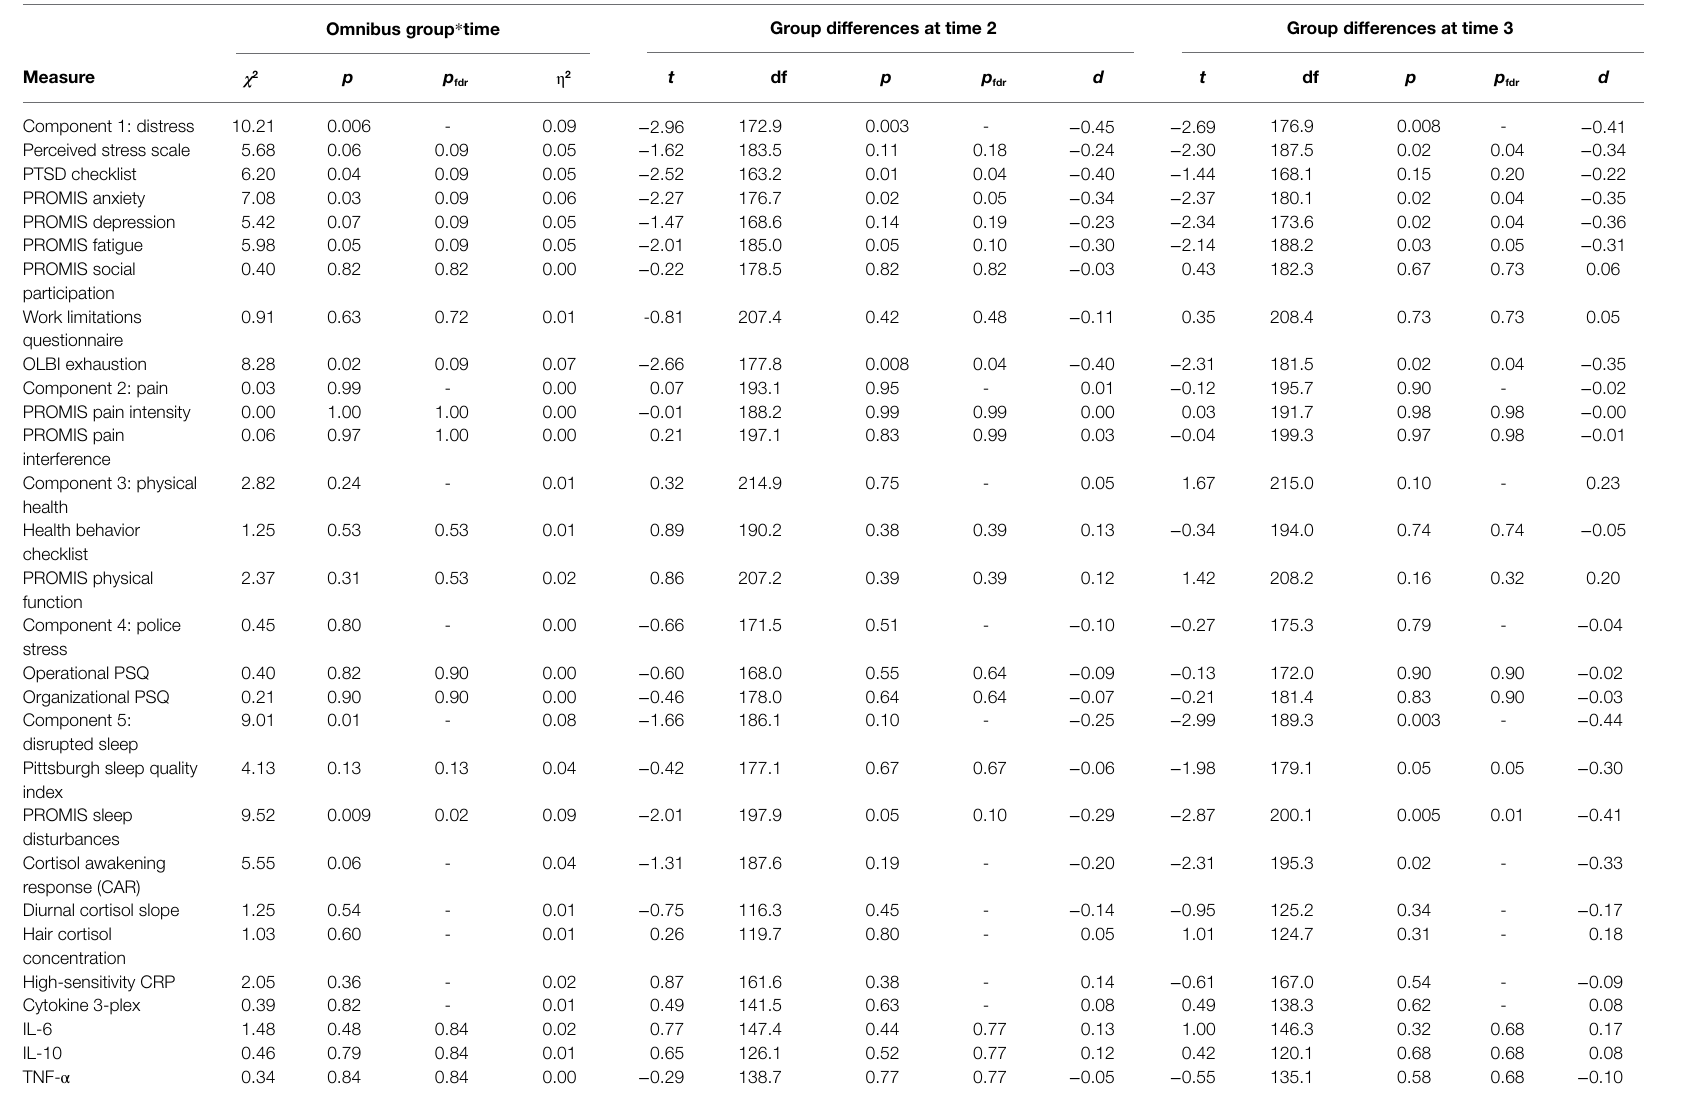
Omnibus group * time Group differences at time 2 Group differences at time